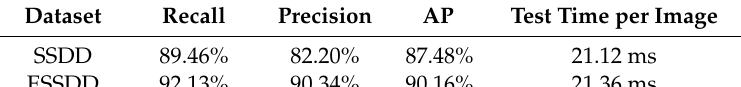
Table 3. The ship test results of SSDD and ESSDD. AP: average precision.